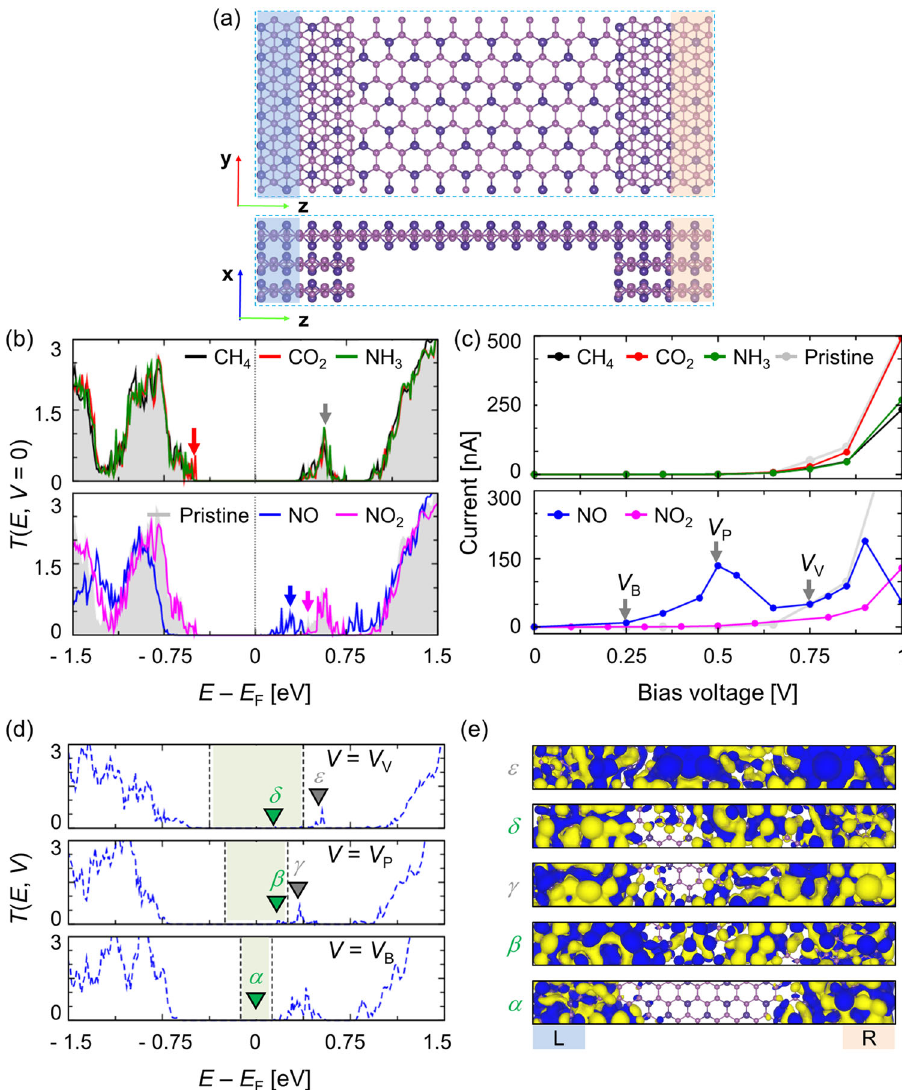
Fig. 4 Zero-bias transmissions and I – V curves of all gas molecules on 313-junction. a Atomic structure of 313-junction with 1L SnP 3 transport channel and 3L SnP 3 electrodes. The device model is constructed with 3L SnP 3 electrodes (highlighted with blue and orange rectangles), overlap regions of 3L SnP 3 as buffers, and a 1L SnP 3 transport channel. b Zero-bias transmission function, T ( E , V = 0) of 313- junction with type A (top) and type B (bottom) molecules adsorbed on top of the transport channel ( T ( E , V = 0) of the pristine SnP 3 313- junction is shown in grey shaded area for comparison), and c corresponding I – V curves. Grey, red, blue, and magenta downwards arrows indicate the electronic states originating from SnP 3 , CO 2 , and NO, and the NO 2 -induced suppression of the T ( E , V = 0) peak near E F , respectively. The I – V curve for the pristine 313-junction is marked as grey lines (see Supplementary Fig. 7). Grey downward arrows indicate the three notable bias voltages in describing NDR, namely, base ( V B = 0.25 V), peak ( V P = 0.50 V), and valley ( V V = 0.75 V) points. d Bias-dependent transmission functions, T ( E , V ), for V B , V P , and V V with the case of NO molecule. For each bias, green and grey downwards triangles correspond to the transmission eigenchannel inside and outside of the bias window (marked as the green shaded area), respectively. The eigenchannels as α E 0 : 0eV are labelled to simplify the convention E eigenenergy 0 : 25V biasvoltage